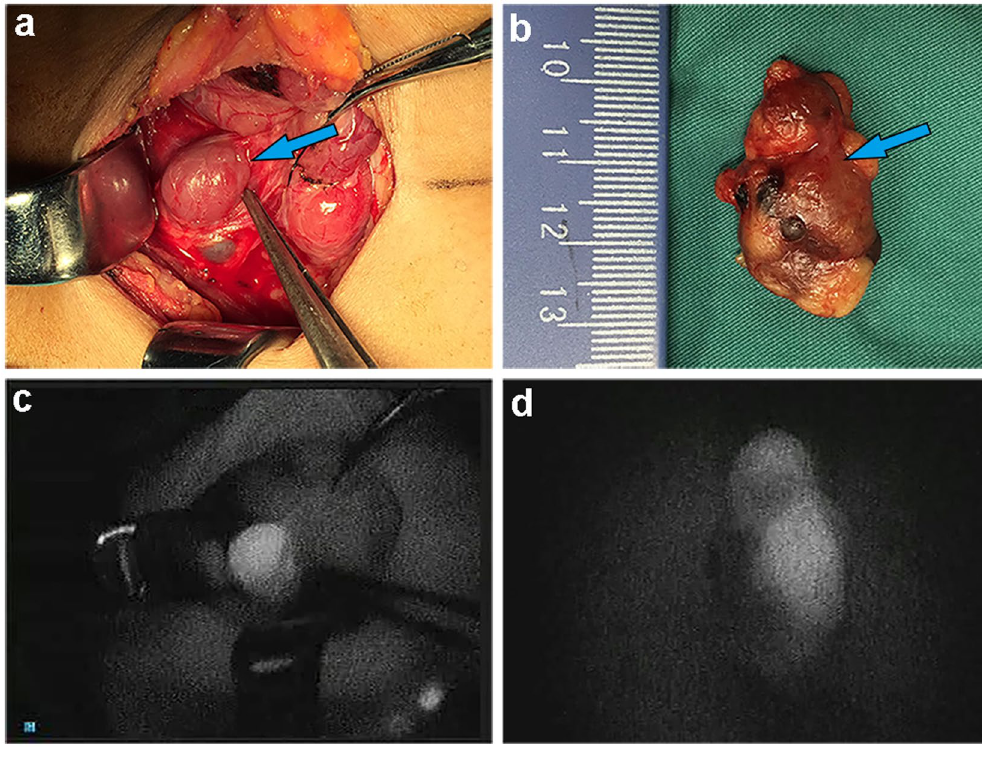
Figure 2. Representative hyperplastic PTG and intraoperative NIRF image using ICG. ( a , b ) Bright-field and ( c , d ) fluorescent images of hyperplastic gland intraoperative and after resection.